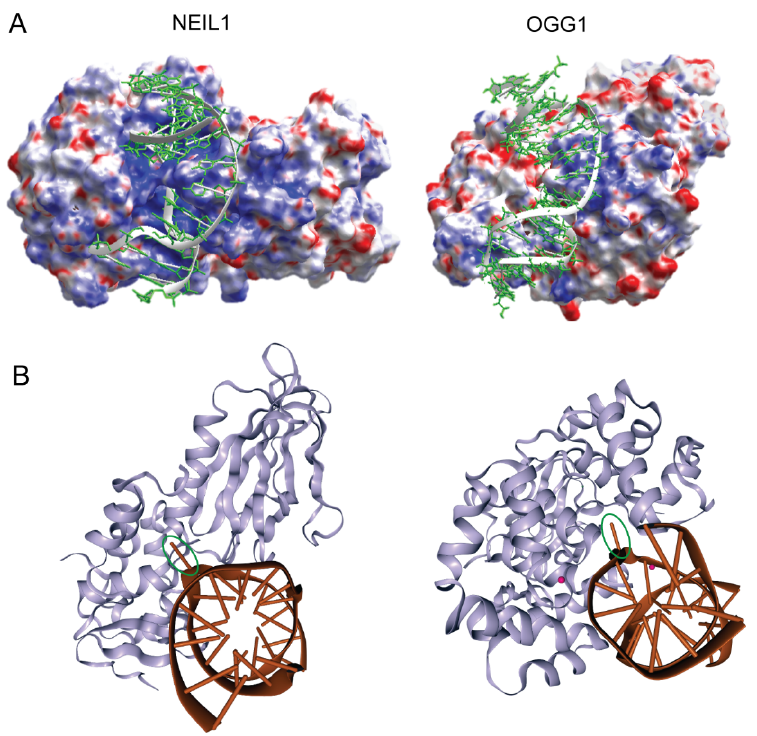
Figure 1. Charge distribution on the surface ( A ) and nucleotide flipping ( B ) in co ‐ crystal structures of DNA glycosylases: The crystallographic coordinates of NEIL1 and OGG1 bound to lesion ‐ con ‐ taining DNA were retrieved from the Protein Data Bank (rcsb.org, last accessed date: 27th February 2020; PDB IDs 5ITX [20] and 1YQR [17], respectively). The images of Poisson–Boltzmann electrostatic potential surface maps were generated using the Schrödinger package (schrodinger.com). The surface is colored according to electrostatic potential (positive: blue; negative: red). The images of glycosylase– DNA complexes were created with NGL Viewer [33] at the RCSB PDB site (rcsb.org). The damaged nu ‐ cleotides (encircled) are at extrahelical positions. This figure was adapted from [34].